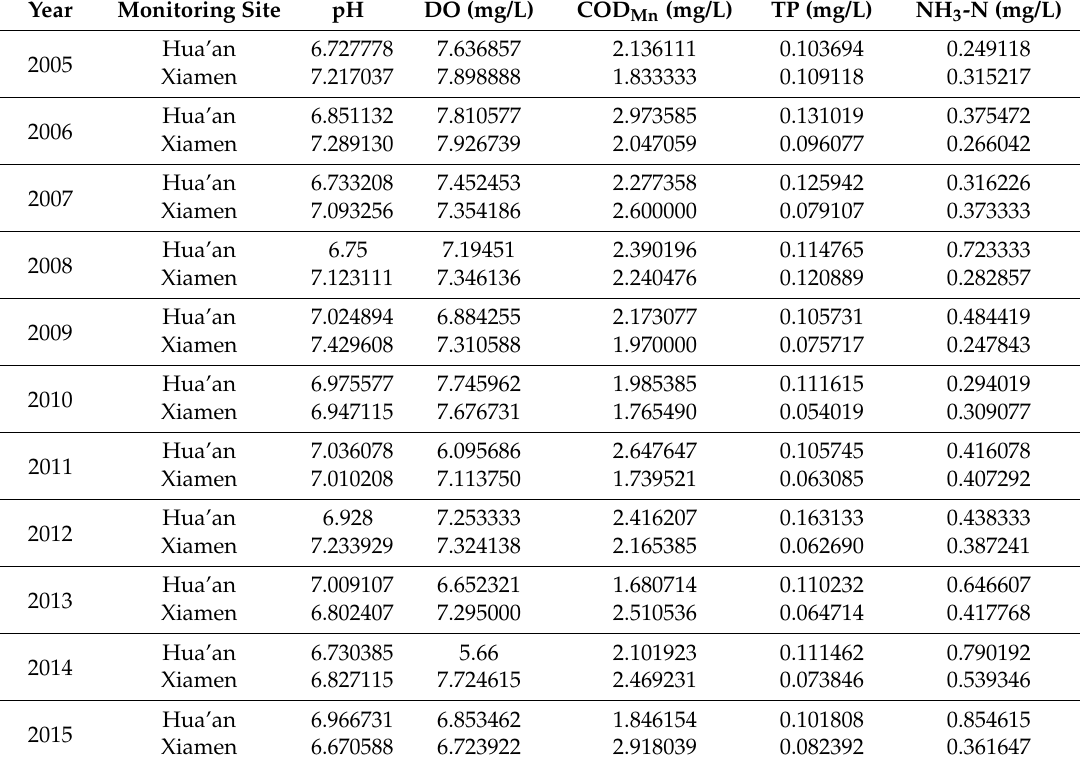
Table 17. The annual water quality indices of two monitoring sites in Jiulong